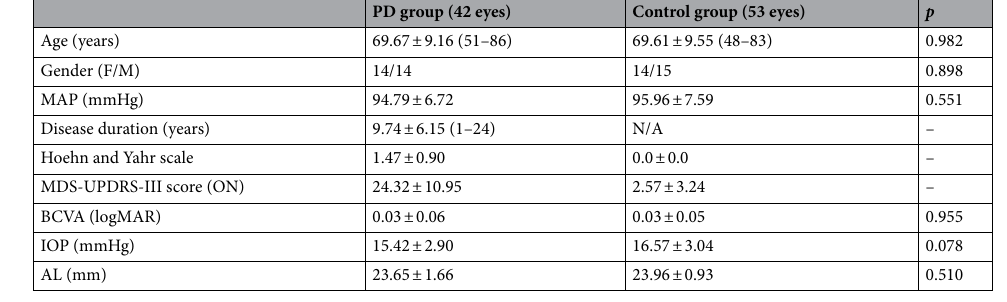
Table 3. Demographic and clinical data of the selected subgroup. AL axial length, BCVA best-corrected visual acuity, F female, IOP intraocular pressure, logMAR logarithm of the minimal angle of resolution, M male, N/A not applicable, MDS-UPDRS Movement Disorder Society Unified Parkinson’s Disease Rating Scale; Results are reported as mean ± standard deviation (range). p < 0.05 was considered statistically significant.